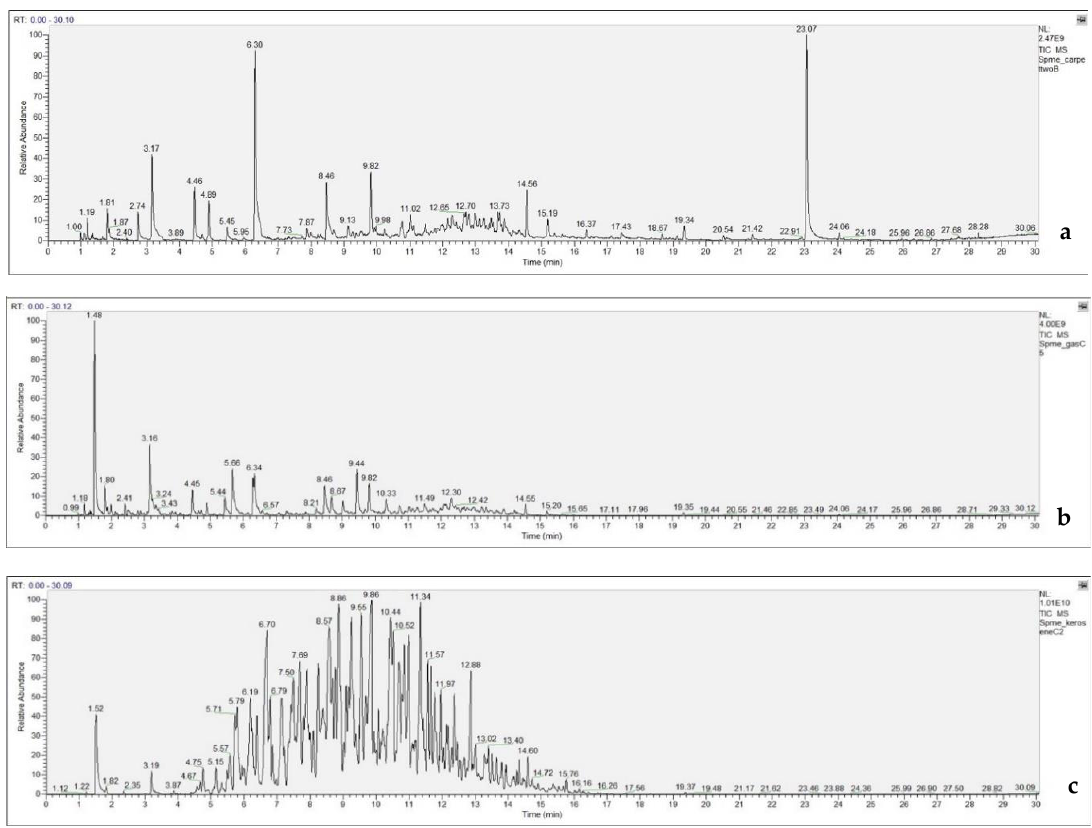
Figure 8. Total ion chromatograms ( m / z 50–500) of carpet #2 ( a ) burned without ILs; ( b ) burned with gasoline; and ( c ) burned with kerosene.